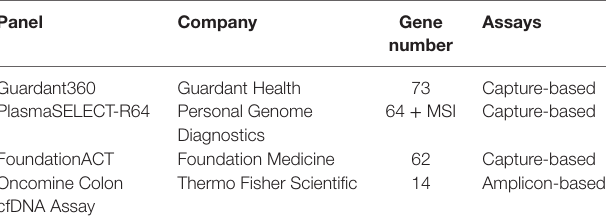
TAbLe 2 | Commercially available circulating tumor DNA next-generation sequencing assays.